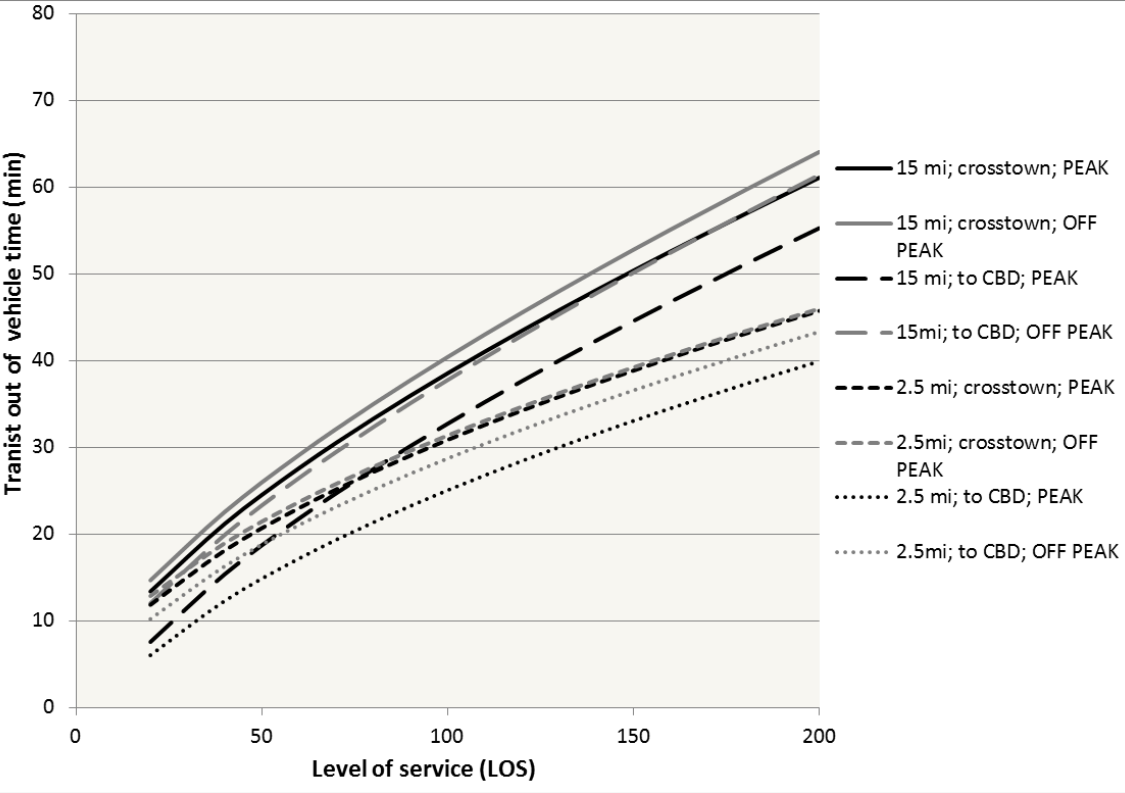
Figure 4. Transit Out-of-vehicle Time Curves for four examples of trip types, by LOS (horizontal axis), for Peak (in black) and Off-Peak (in gray)